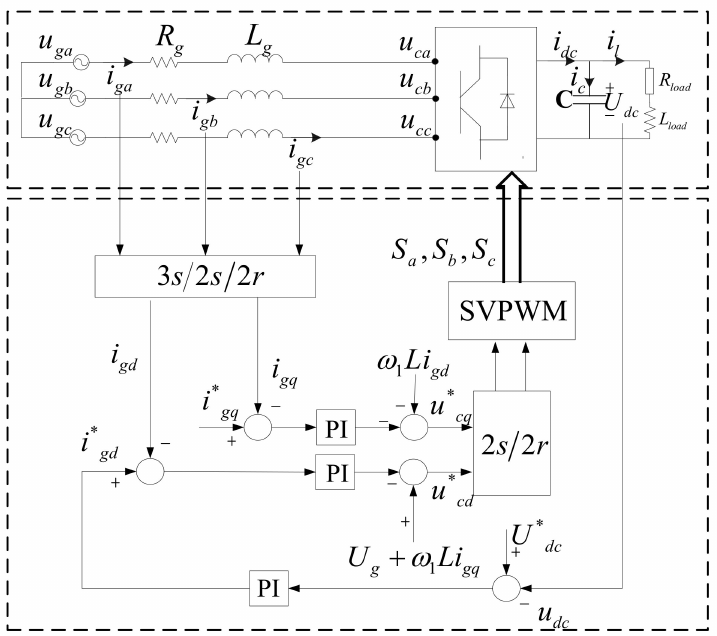
Figure 3. The dq decoupled control of GSC. SVPWM: space vector pulse width